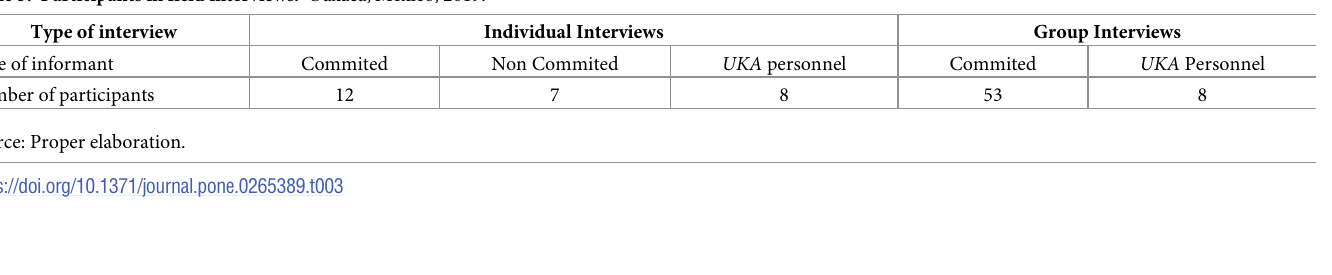
Table 3. Participants in field interviews. Oaxaca, Me´xico,